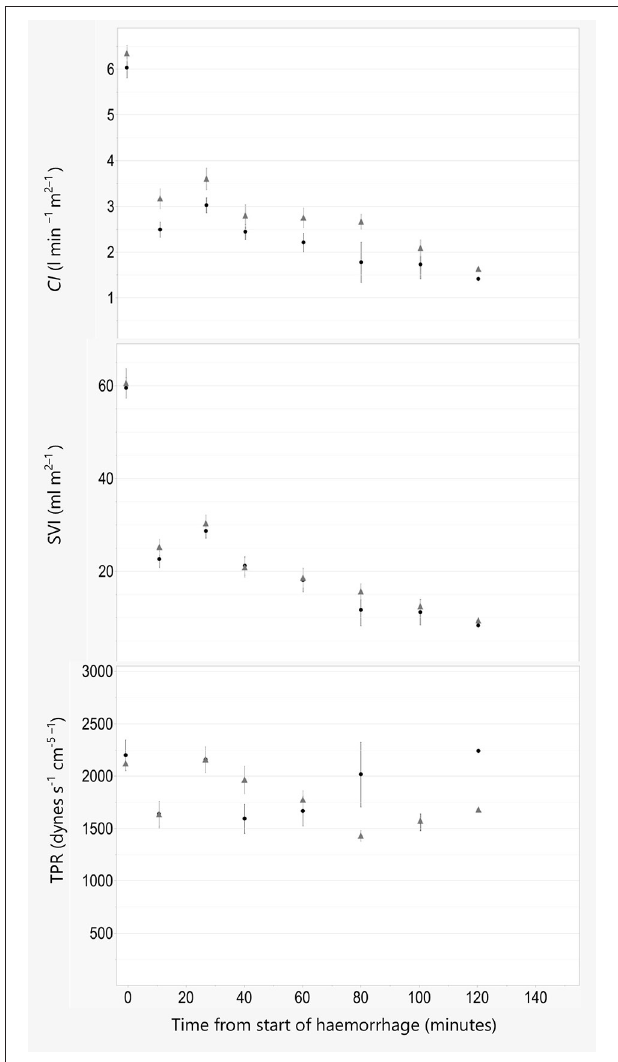
FIGURE 4 | Cardiac index, stroke volume index, and total peripheral resistance. Data are plotted against time in minutes from start of hemorrhage. Cardiac index ( CI ), stroke volume index (SVI), and total peripheral resistance (TPR) are illustrated as Mean ± SEM, and black line and filled circles represent pigs anesthetized with propofol 8mg kg − 1 h − 1 . Gray line and triangles represent pigs anesthetized with alfaxalone 5mg kg − 1 h − 1 . In addition, all pigs were administered ketamine 5mg kg − 1 h − 1 and dexmedetomidine 4 µ g kg − 1 h − 1